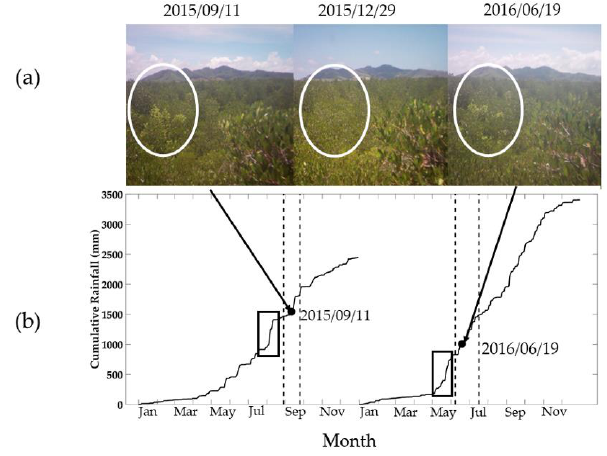
Figure 8. The timing of the appearance of new leaves as assessed by visual observation of phenocam-1 images. The new leaf growth was observed on 11 September 2015 and 19 June 2016. ( a ) The white circles in the top of the canopy images show the new leaf growth. ( b ) Plot of the cumulative rainfall from January to December for 2015 and 2016, with the dashed lines showing the time interval of the new mangrove leaf appearance. The two rectangles indicate the periods of rapid rainfall accumulation. Sprouting of new leaves occurs about 2 weeks after a major wet event.